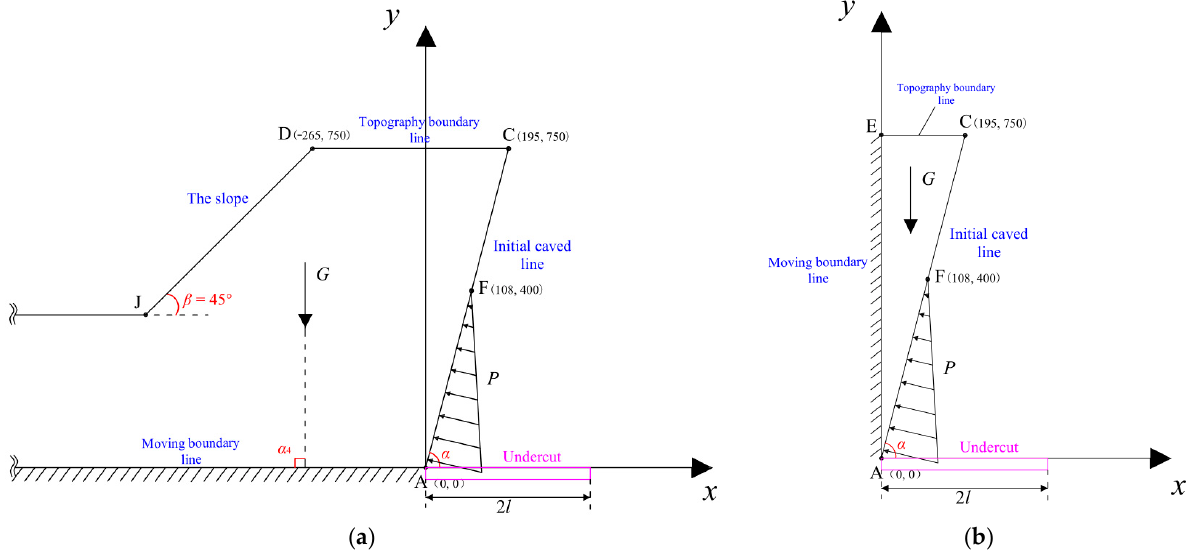
Figure 8. Mechanical models under two exceptional cases. ( a ) The mechanical model with α 3 = 0°; ( b ) the mechanical model with α 3 = 90°. ( b ) the mechanical model with α 3 = 90 ◦ .